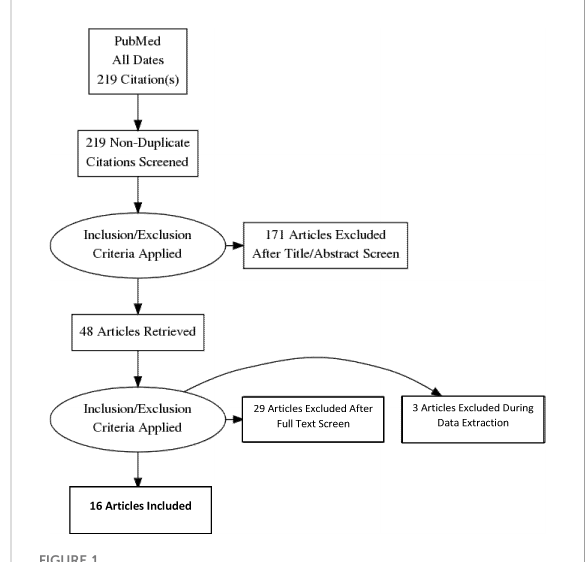
FIGURE 1 Preferred reporting Items for systematic reviews and meta- analyses fl ow diagram of the search